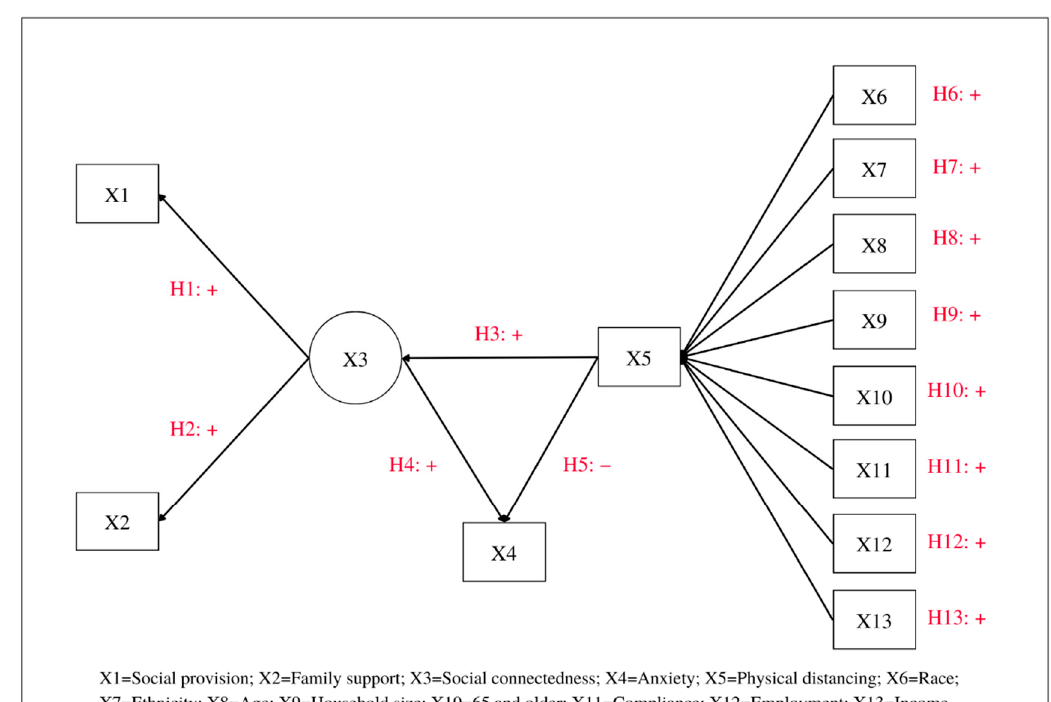
Figure 1. A Hypothesized Structural Equation (SEM) Model of Social Connectedness, Physical Distancing, and Anxiety (SCPDA).